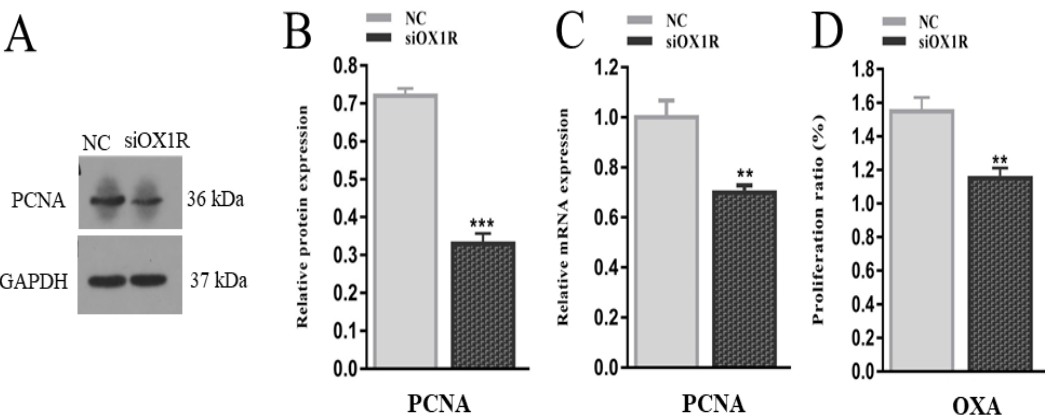
Figure 6. Knockdown of OX1R suppressed proliferation of mouse GCs. ( A – C ) The expression of the proliferation marker gene, PCNA, at the protein and mRNA levels was analyzed using Western blotting and RT-qPCR in mouse GCs after siOX1R and NC transfection for 48 h. ( D ) The proliferation rate of siOX1R-transfected GCs groups and the negative control groups were evaluated using the CCK-8 assay. The results are shown as the means ± SEM, and significant differences are indicated with error bars with asterisks (** p < 0.01 and *** p < 0.001). NC, Negative control; siOX1R, orexin receptor type 1 siRNA; OX1R, orexin receptor type 1; GCs, granulosa cells.